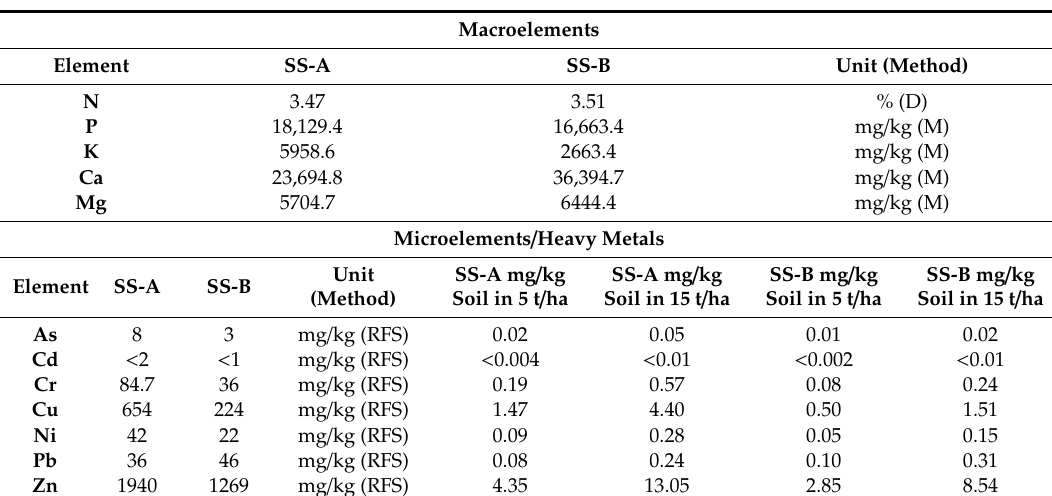
Table 1. Analysis of elements in used sewage sludge from Gy˝or, Hungary (SS-A) and Piešt’any, Slovakia (SS-B), and the conversion of heavy metal content to 1 kg of soil supplemented with sewage sludge in the dose of 5 t / ha and 15 t /